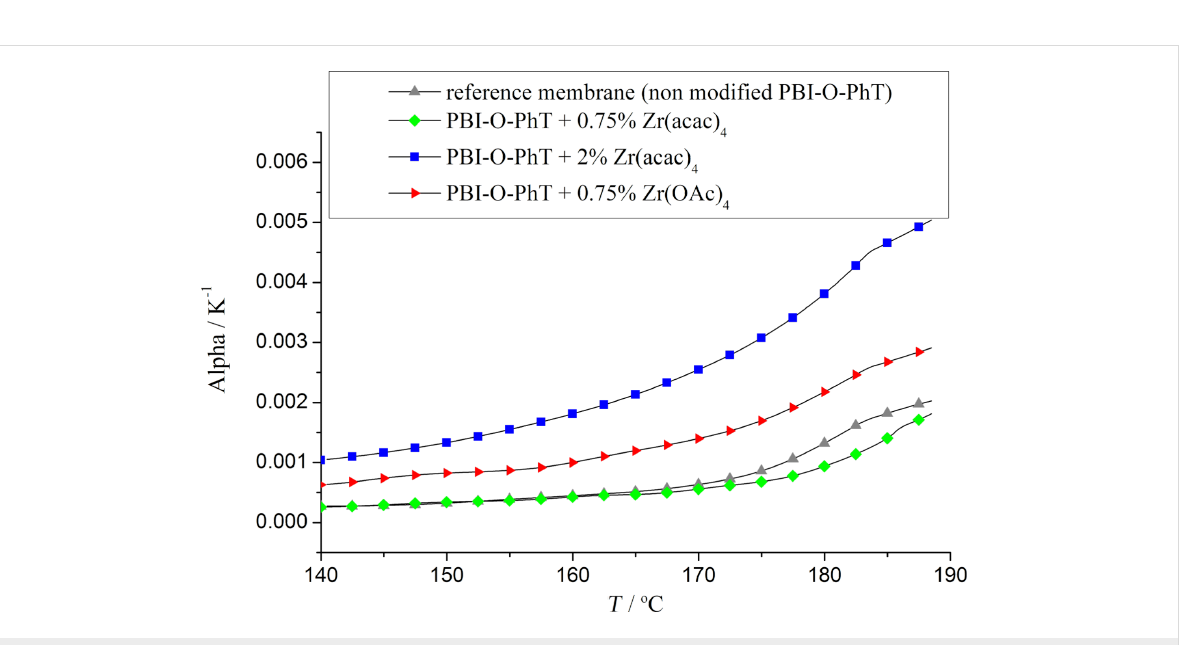
Figure 7: Thermal expansion coefficients of the composite